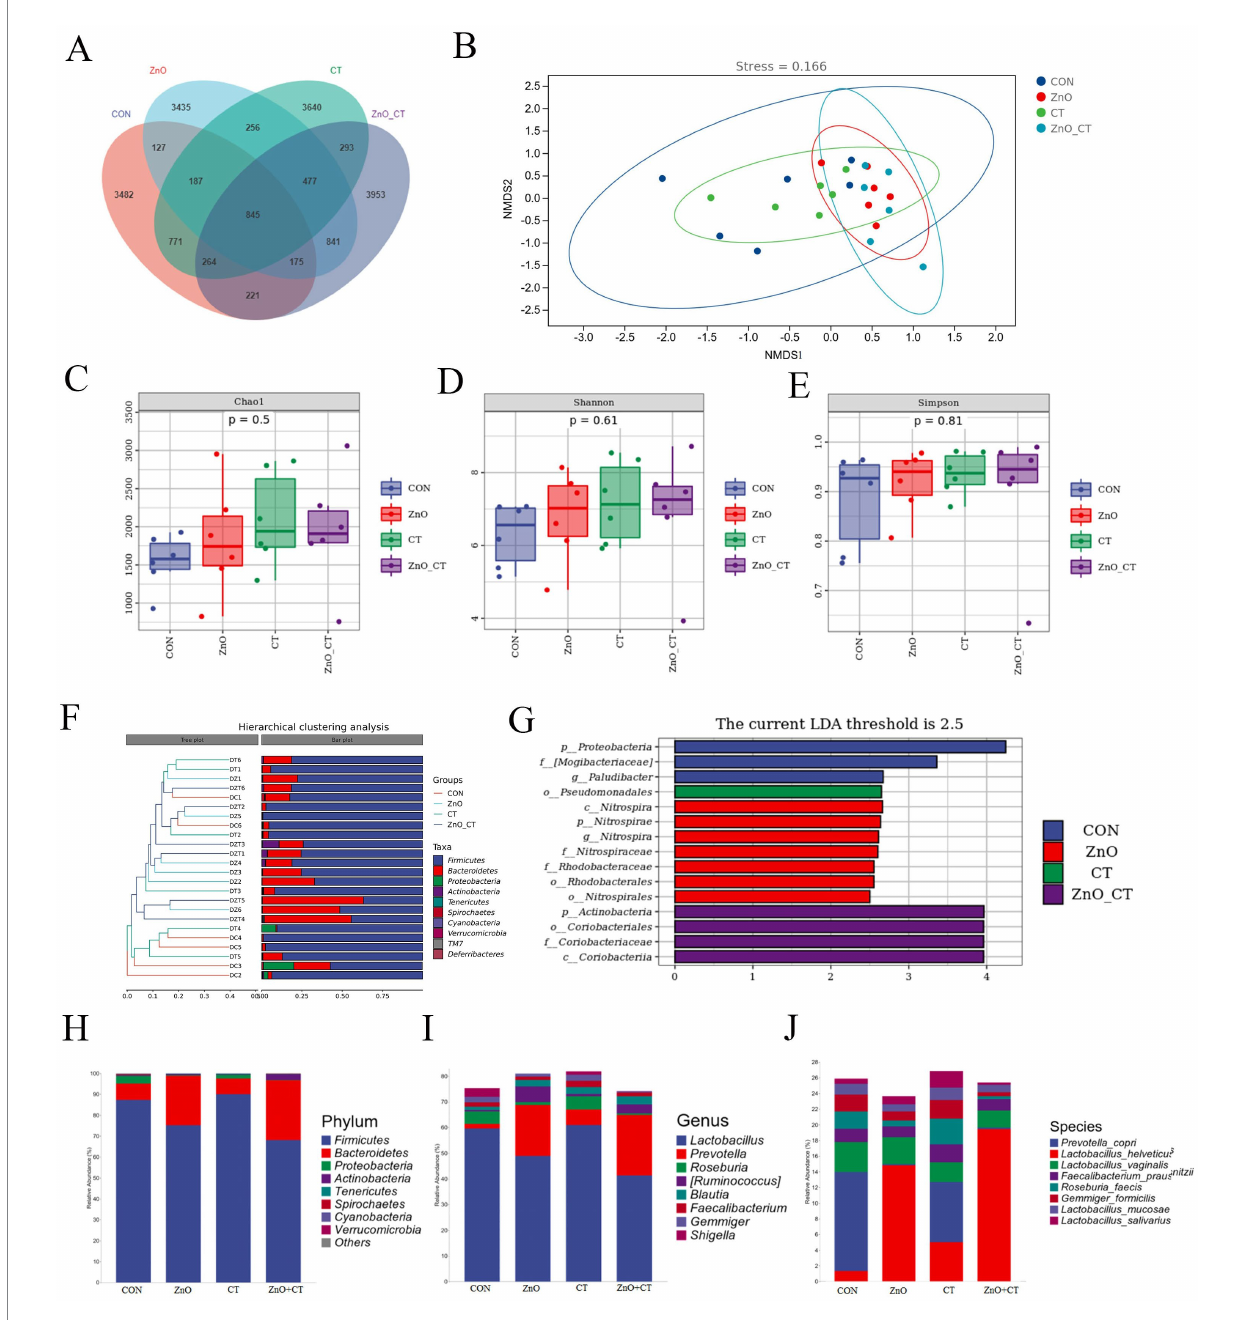
FIGURE 5 Effects of ZnO and CT on colonic microflora species composition of weaned piglets in K88-challenged environment. (A) Venn diagram illustrating common and special OTUs distributed among the four groups. (B) OUTs-based NMDS plot. (C–E) Species diversity and homogeneity were evaluated using Chao1, Shannon’s, and Simpson’s indices. (F) UPGMA clustering was conducted based on unweighted UniFrac distance. (G) Significantly different biomarkers in the four groups. (H–J) Effects of ZnO and CT on the composition of colonic microbiota in weaned pigs at the phylum, genus and species